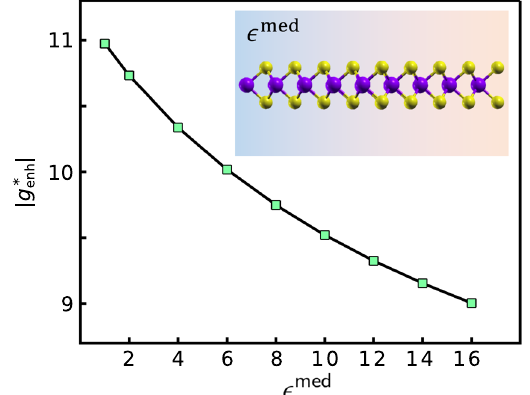
j using dielectric screening. Ab initio Fig. 5 Tunability of j g (cid:2) enh valence band g-factor j g (cid:1) j as a function of background dielectric enh constant ϵ med for a hole density of 5.18 × 10 12 cm − 2